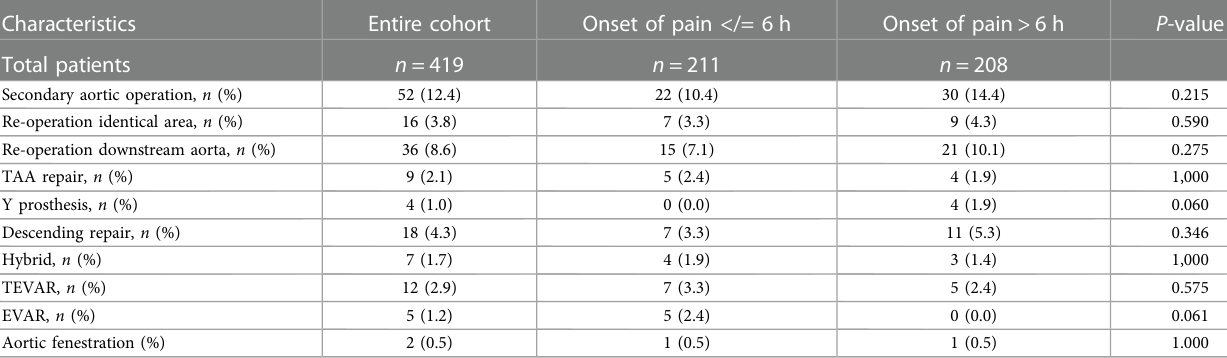
TABLE 5 Follow-up data: TAA, thoraco-abdominal aneurysm; TEVAR, thoracic endovascular aortic repair; EVAR, endovascular aneurysm repair.